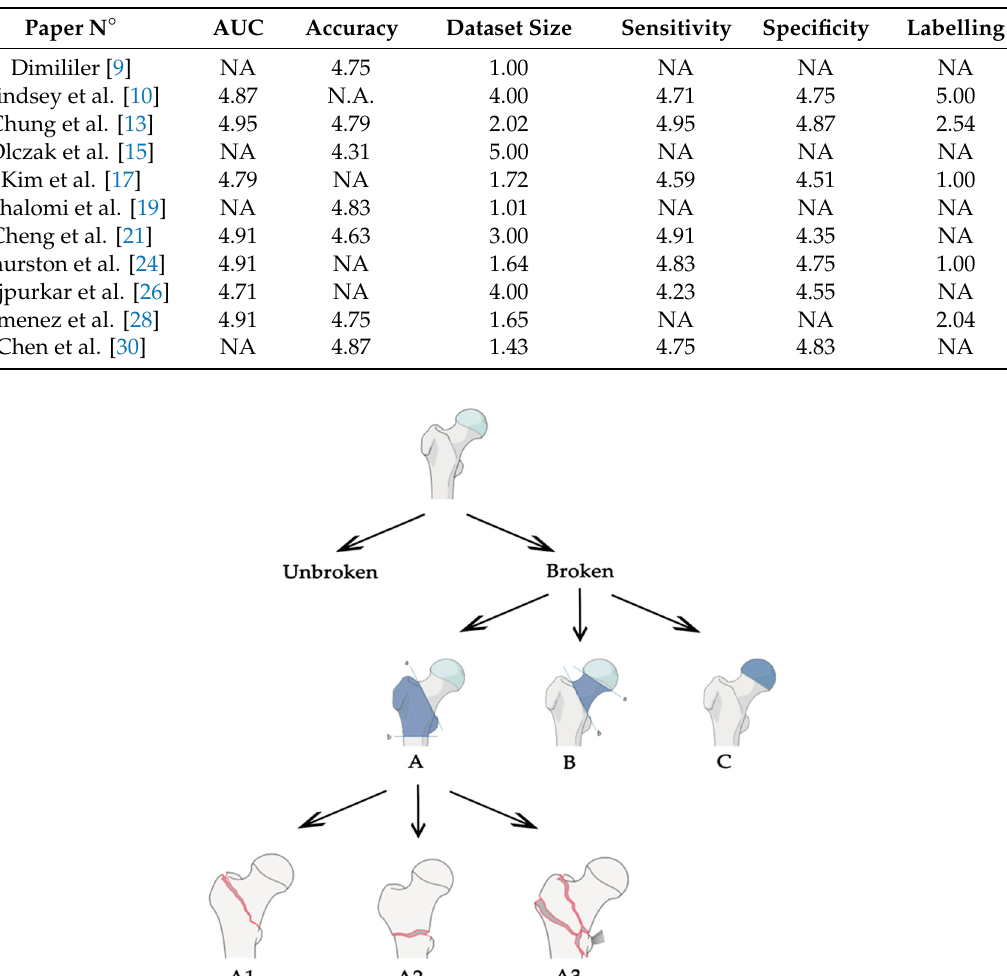
Table 2. Values extracted from Table 1 and mapped in the range from 1 to 5. In case of multiple and binary results we used just the binary one in order to relate di ff erent studies. For the dataset size, we considered [10,15,26] as outliers and mapped them to the values of 5 and 4. We then mapped the other values from 1 to 3. For the labelling, we computed the values using the formula